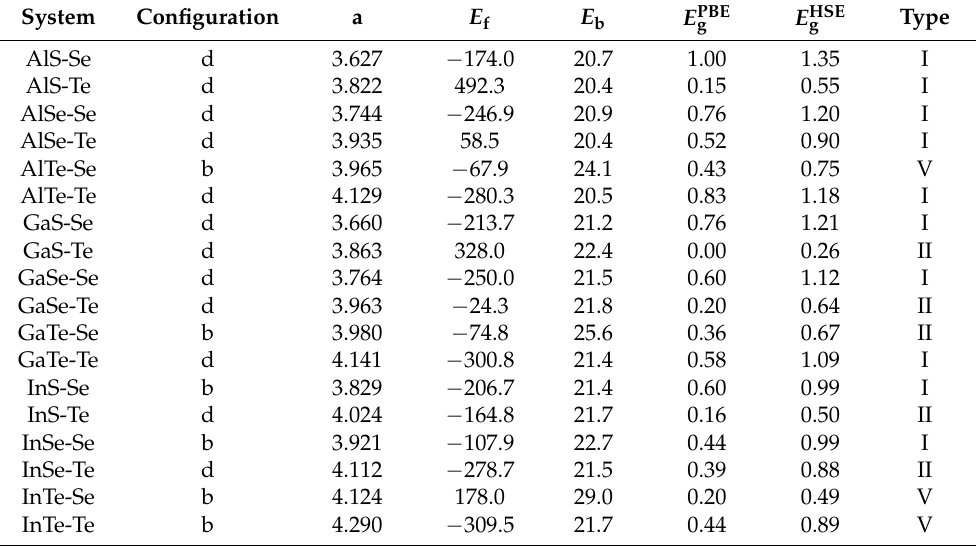
Table 1. Most stable configurations, lattice constants a (Å ), formation energies E f (meV), binding energies E b (meV/Å 2 ), PBE, and HSE band gaps E g PBE (eV) and E gHSE (eV), and band edge alignment types for MX A /X B vdW heterostructures.